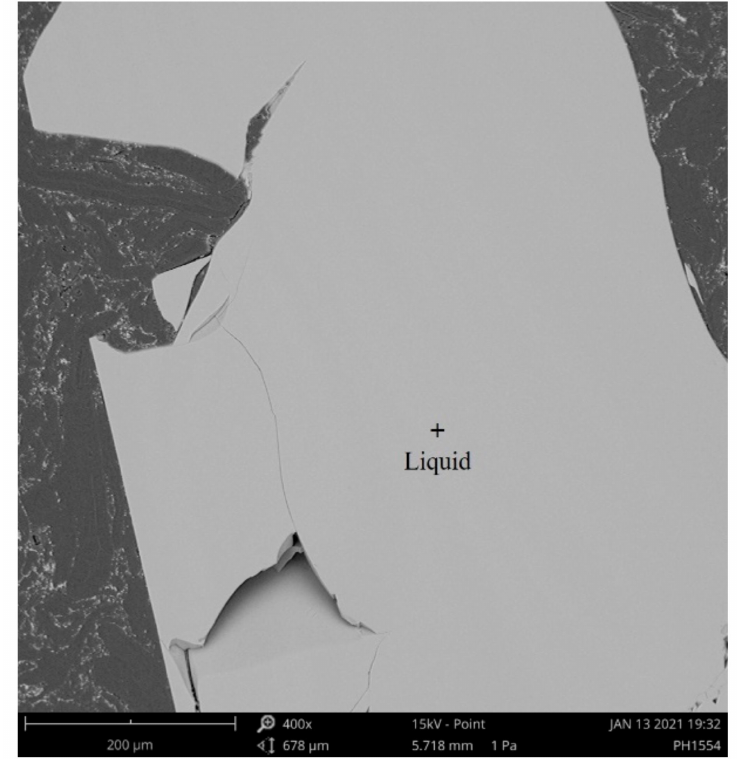
Figure 1. SEM photo of pre-melt slag